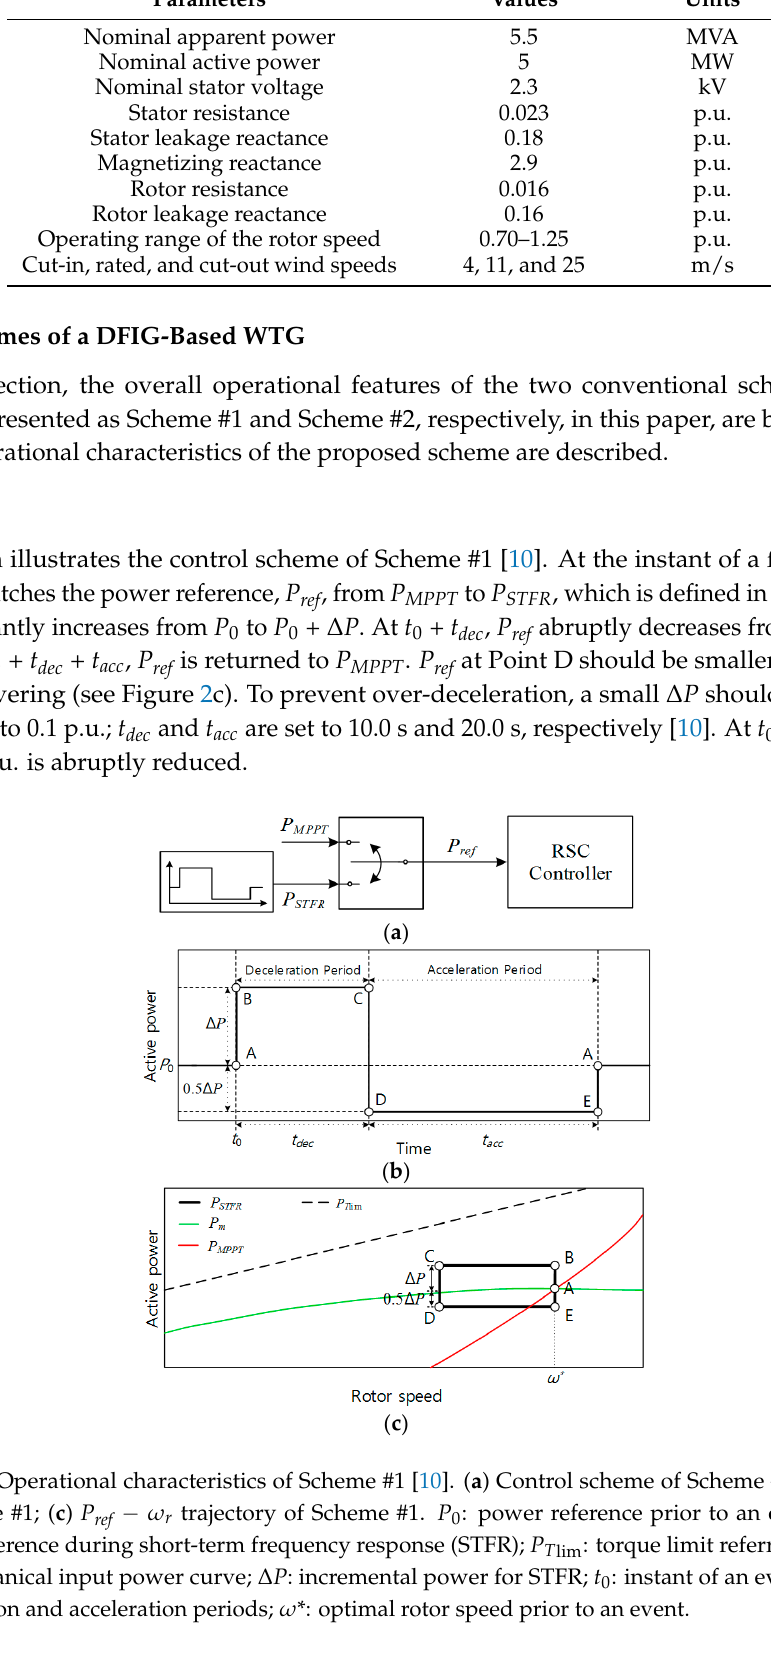
Table 1. DFIG-based WTG parameters.